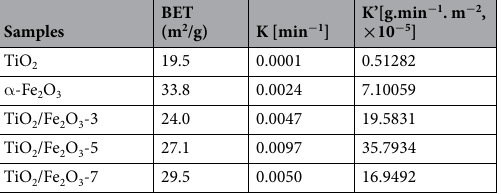
Table 1. BET surface area, reaction rate constant and normalized rate constant of TiO 2 , α -Fe 2 O 3 and TiO 2 / Fe 2 O 3 composites.